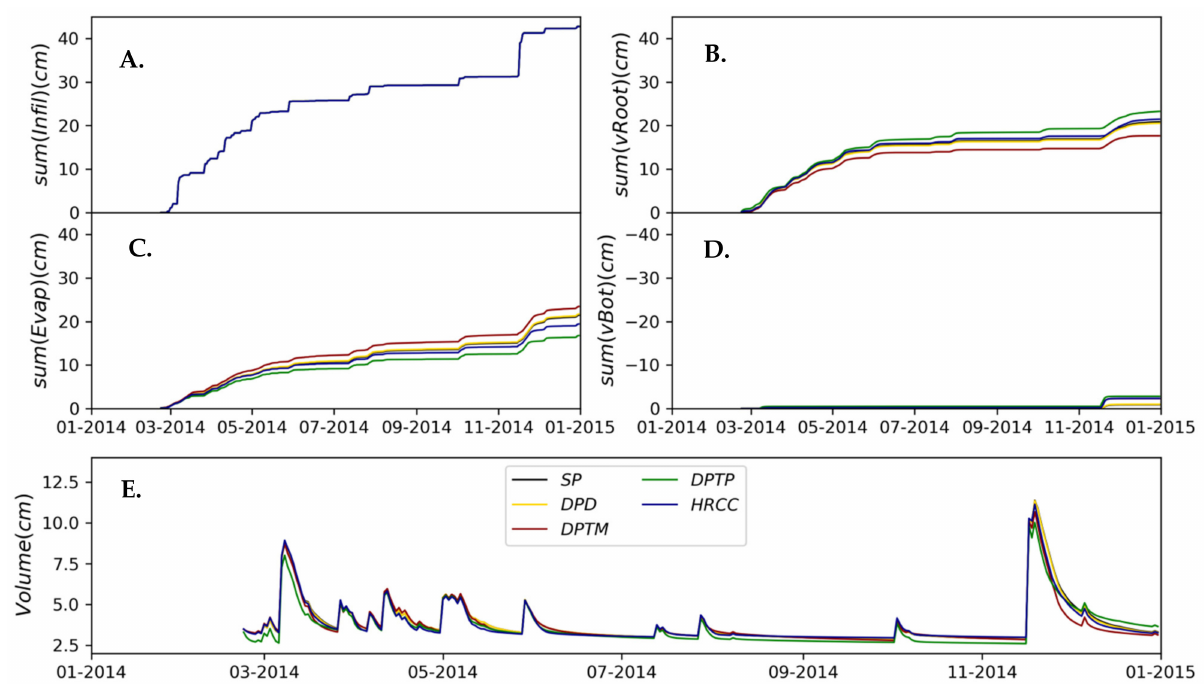
Figure 8. Cumulative flows in 2014 for the BR-CST tower with the SP, DPD, DPTM, DPTP, and HRCC models. Where ( A ). sum(Infil)—accumulated infiltration; ( B ). sum(vRoot)—accumulated root water uptake; ( C ). sum(Evap)—accumulated evaporation; ( D ). sum(vBot)—accumulated bottom discharge; ( E ). Volume—soil water